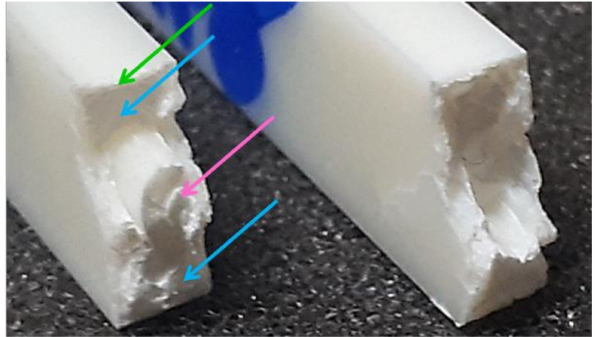
Figure 7. Picture of a Charpy post-mortem dogbone of ABS + 8 wt% PP—arrows indicate different areas.